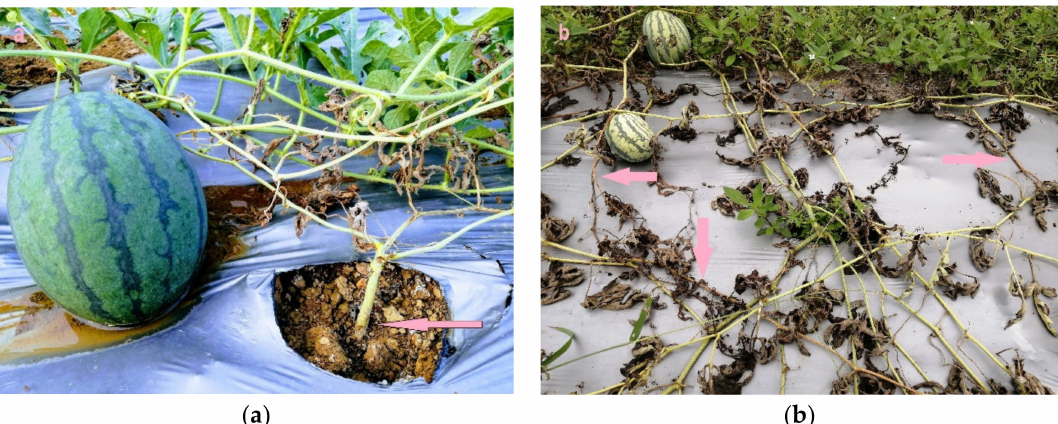
Figure 2. Wilting disease symptoms of watermelon plants caused by Fusarium oxysporum f. sp. niveum under field condition. ( a ) Showing brown necrotic lesions at the base of the stem. ( b ) Showing a severe form of wilting, laterally the whole plant wilted and died. Pictures are from the personal collection of M. Z. Rahman collected during the field